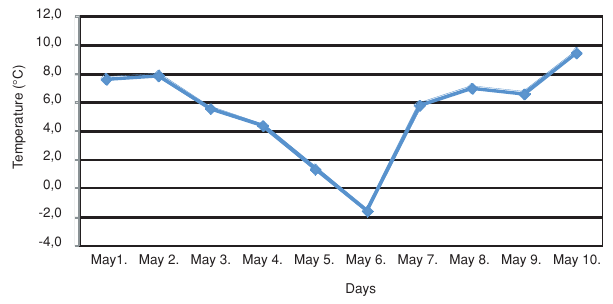
Figure 1. Minimum temperature degree at 2m (Újfehértó, V.1.2011. – V.10.2011.) Table 1. Data of air temperature (V.1.2011. – V.10. 2011.) Meteorological data of Research Station at